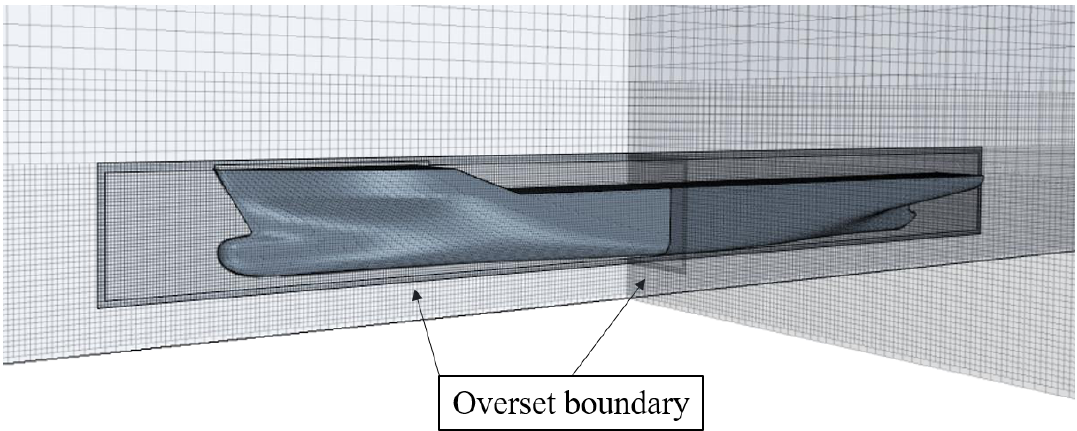
Figure 4. Three-dimensional depiction of the computational mesh.